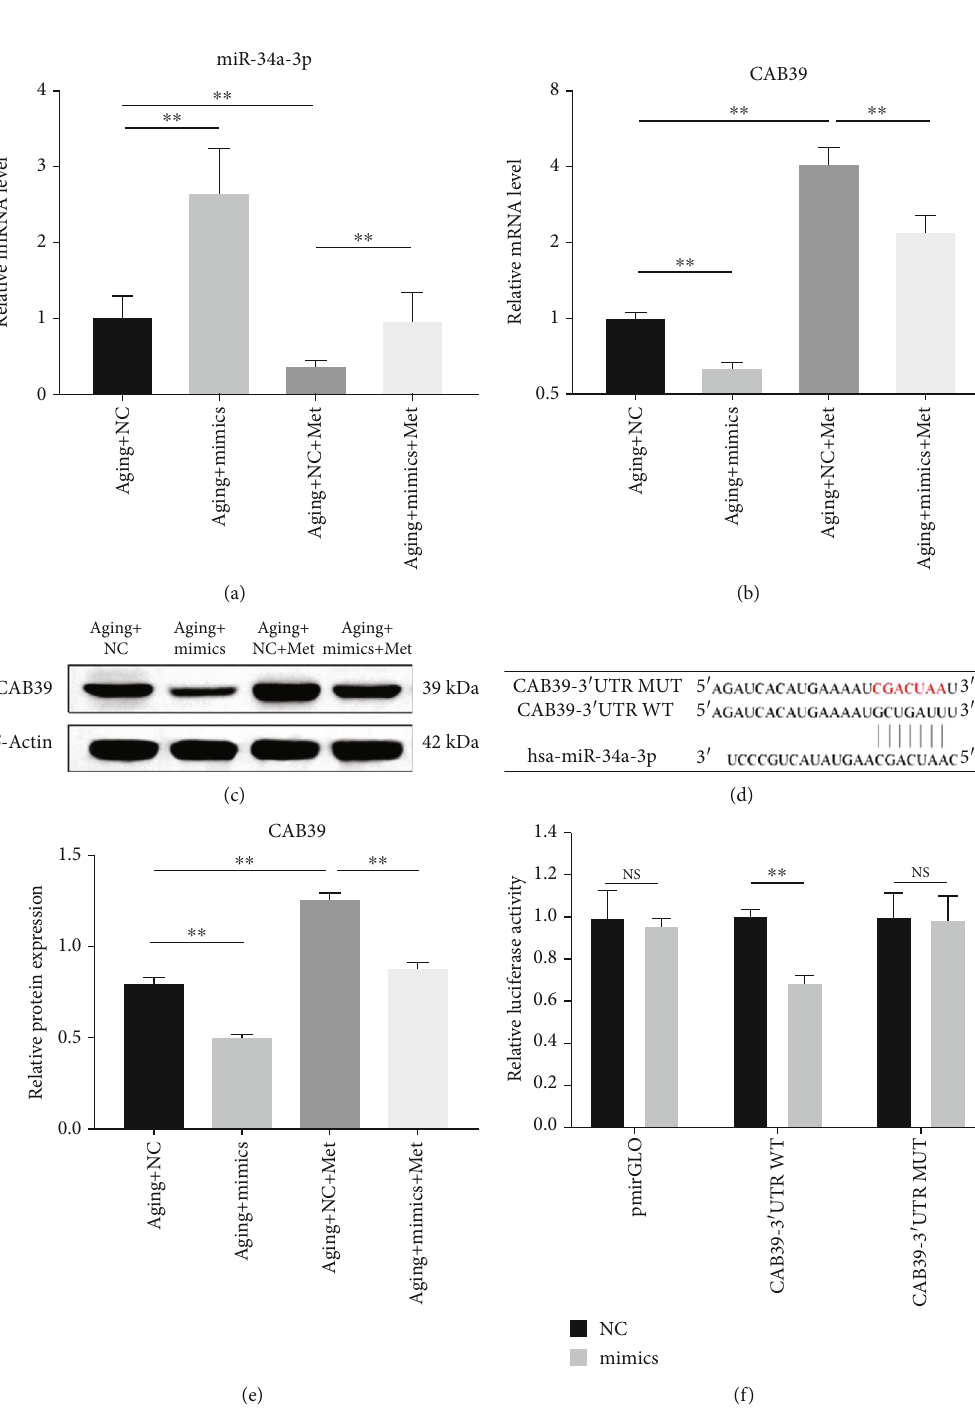
Figure 5: miR-34a-3p downregulates CAB39 expression. (a) Relative expression levels of miR-34a-3p and (b) CAB39 were determined by RT-qPCR in aging DPSCs transfected with miR-34a-3p mimics or miR-NC for 48 h followed by 100 μ M metformin for 48 h. (c) Representative blots and (e) quantitative analysis of CAB39 protein expression levels in aging DPSCs transfected with miR-34a-3p mimics or miR-NC for 48h followed by 100 μ M metformin for 48h. (d) The predicted potential binding site of miR-34a-3p at the 3 ′ UTR of CAB39 in the human gene is shown. Meanwhile, a mutation was constructed where the letters in red indicate mutated nucleotides. (f) Relative luciferase activity. Data are expressed as mean ± standard deviation ( n = 3 ). NS: not signi fi cantly di ff erent. ∗∗ p < 0 : 01 , with comparisons indicated by